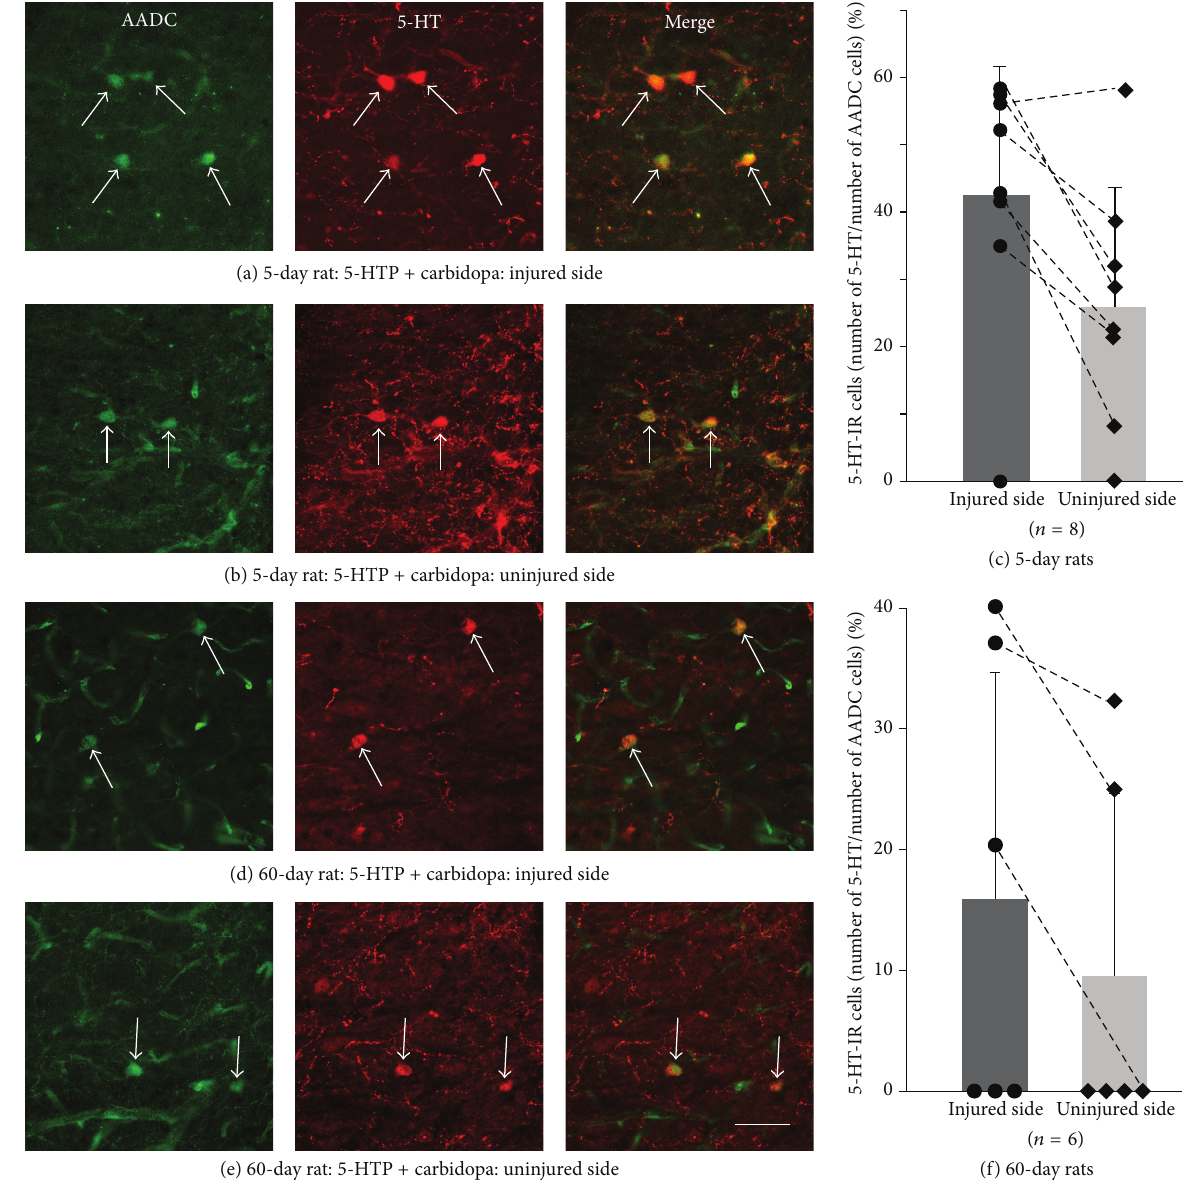
Figure 3: 5-HT expression in AADC cells in the intermediate zone in the sacrocaudal spinal cord on the injured and uninjured side in the animal groups injected with 5-HTP and carbidopa. (a) Photomicrograph showing 5-HT-immunoreactive (IR) AADC cells on the injured side in a rat at 5 days after injury. (b) On the uninjured side in a rat at 5 days after injury. Arrows indicate the 5-HT-IR AADC cells. (c) Group data of the incidence of 5-HT-IR AADC cells on the injured side with respect to uninjured side. Dots/squares represent data from different individual cases. Dashed lines connect the data from the same cases. There was significant difference of 5-HT-IR cells between the two sides ( ∗∗ 𝑃 < 0.05 ). (d–f) Data from 60-day postinjury group with the same format as in 5-day postinjury group.